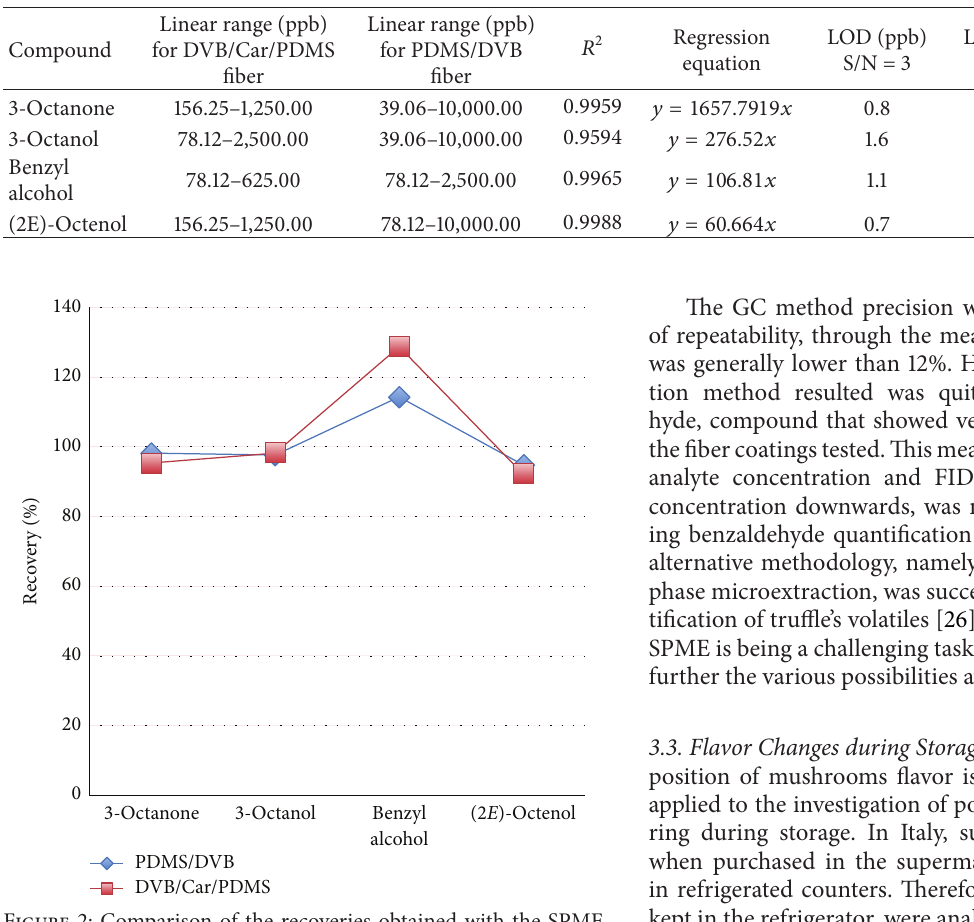
Table 3: Validation data for predominant volatiles of Agaricus bisporus : linear regression data, limit of detection (LOD), limit of quantification (LOQ), and recovery values (average of three analyses).